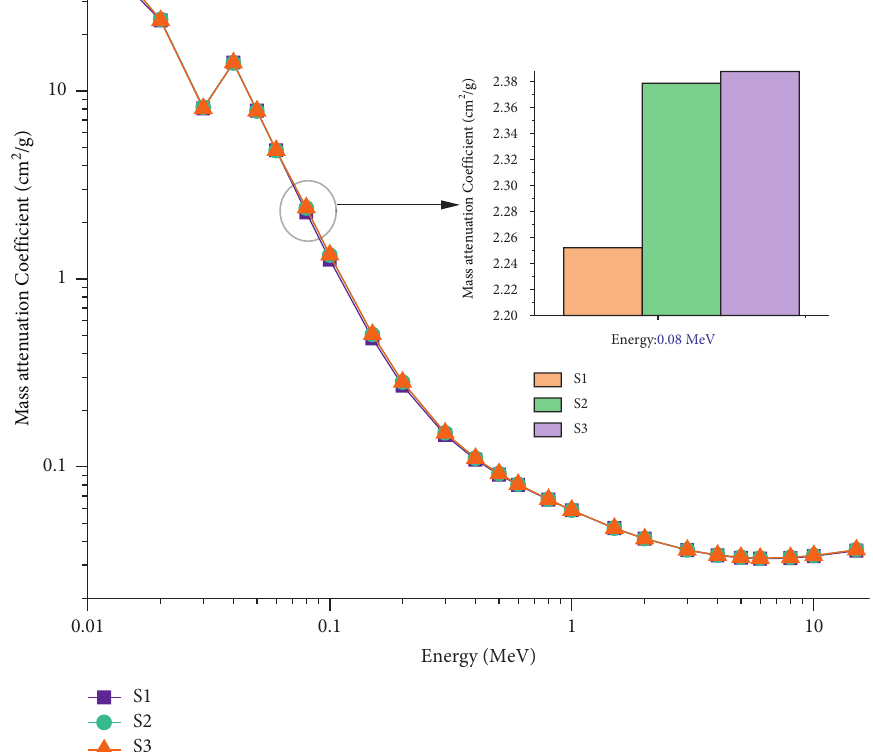
Figure 4: Variations of the mass attenuation coefficient (cm 2 /g) with photon energy (MeV) for all S1–S3